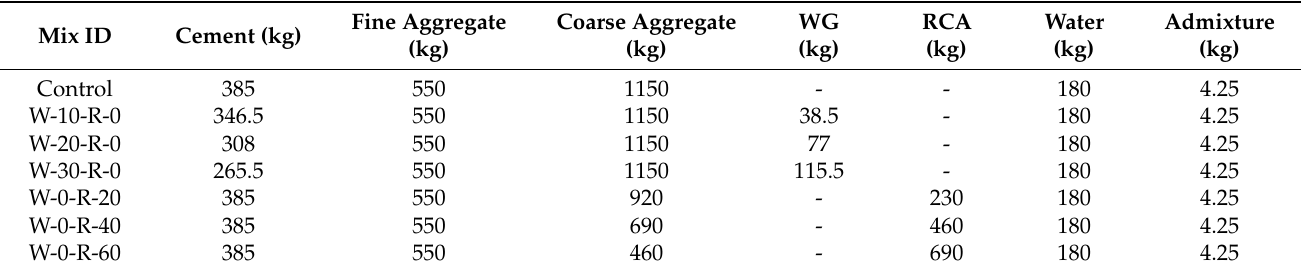
Table 4. Quantification of materials per cubic meter.